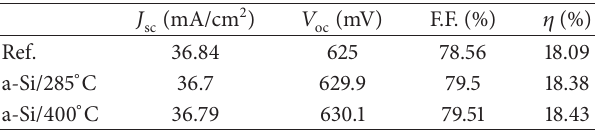
Table 3: Electrical parameters and conversion efficiencies mea- sured, in a different set of experiments, for a reference cell (Ref.), and back-surface a-Si:H deposited cells annealed at 285 ∘ C (a-Si/285 ∘ C) and 400 ∘ C (a-Si/400 ∘ C). All of these cells have a homogeneous